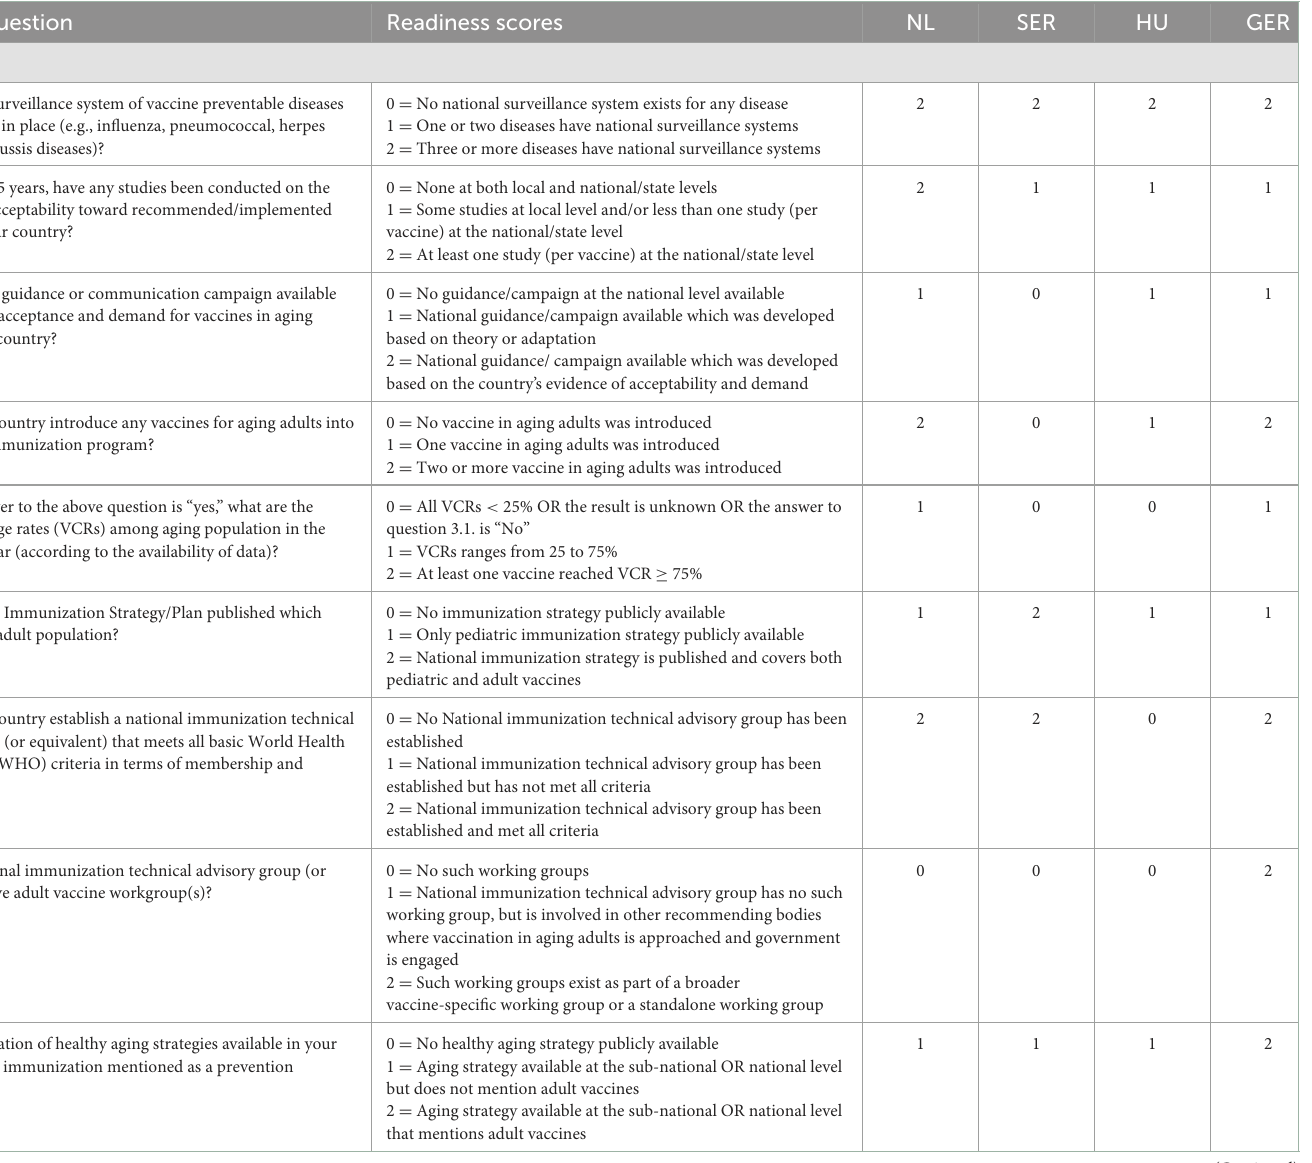
TABLE 4 The final version of the country score tool ( ∗ ) and readiness scores in four pilot countries. Domain Guiding question Readiness scores NL SER HU GER Decision-making